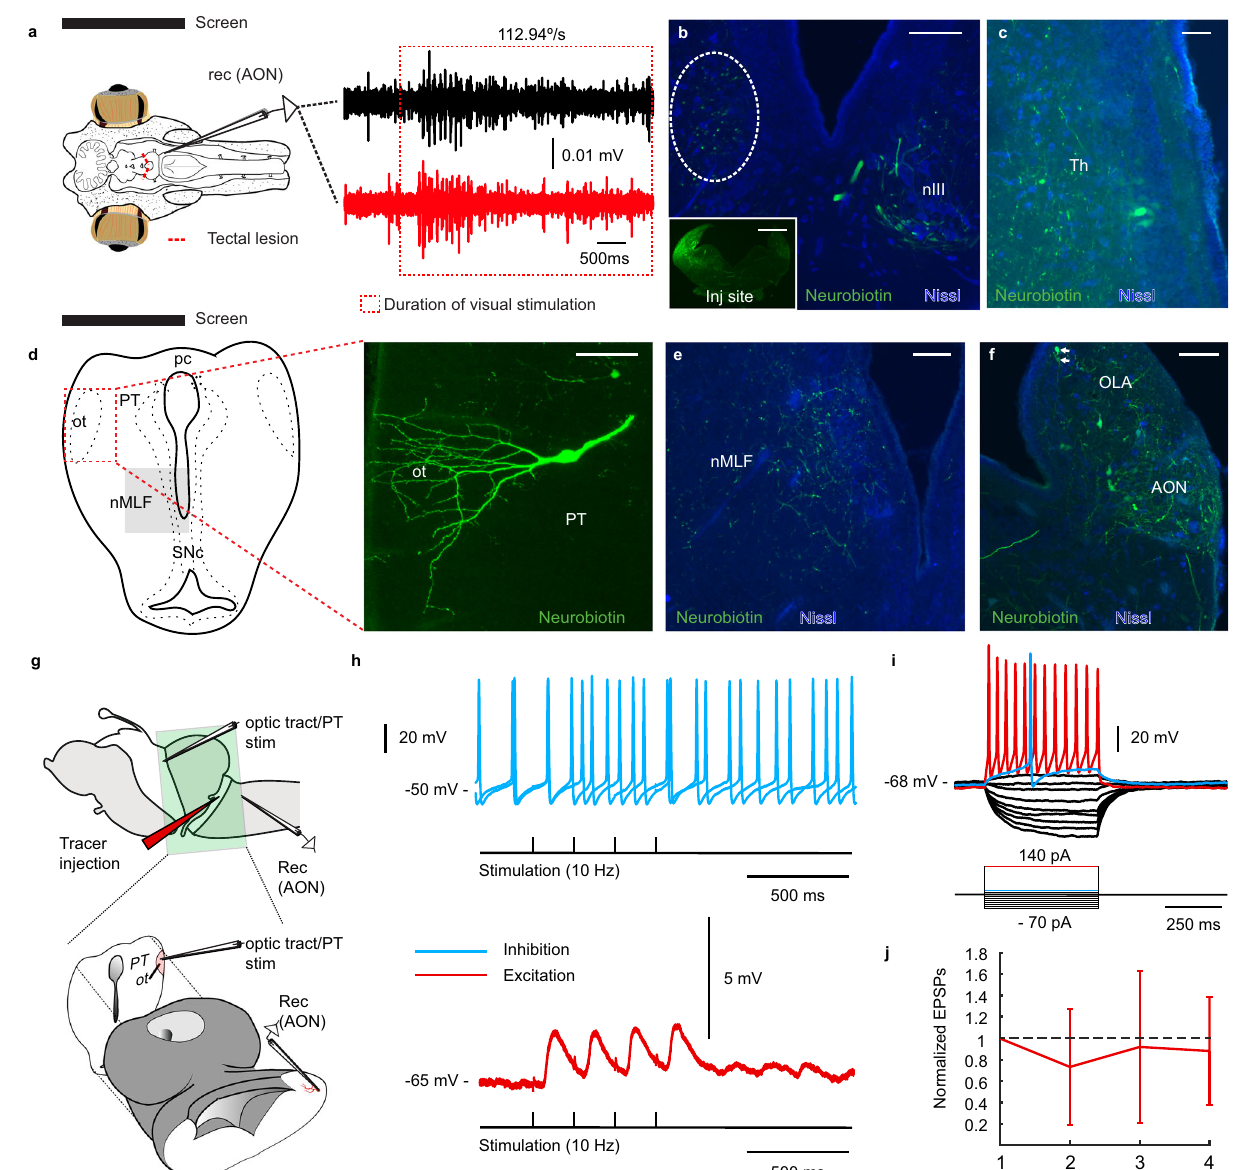
Fig. 7 | Visual inputs to the vestibular nucleus. a (left) Recordings in the AON in response to optokynetic stimulation during normal conditions (black trace) and aftertectallesioning(redtrace).Thereddottedrectangleindicatesthedurationof the visual stimulation. b Anterogradely labeled fi bers terminating in the con- tralateral nIII, after a neurobiotin injection into AON (inset). Labeled fi bers also course more caudally towards the nMLF (dashed oval; see e ). c Retrogradely labeledcellswerefoundintheipsilateralthalamus d Retrogradelylabeledcellscan be seen in pretectum (right) with dendrites reaching into the optic tract. e Terminals in the ipsilateral nMLF. f Contralateral projections at the level of the injection site, revealing signi fi cant cross-talk between vestibular areas. g A sche- matic showing the thick section of the lamprey brain used for intracellular patch- clamp recordings, maintaining the pretectum and exposing AON for whole-cell recordings.AtracerinjectionwaspreviouslymadeinthetractfromtheAONtothe nIII, at the level of the isthmus, allowing for visualizing projection neurons in the AON for whole-cell recordings. h Excitatory (bottom, red trace) responses of a